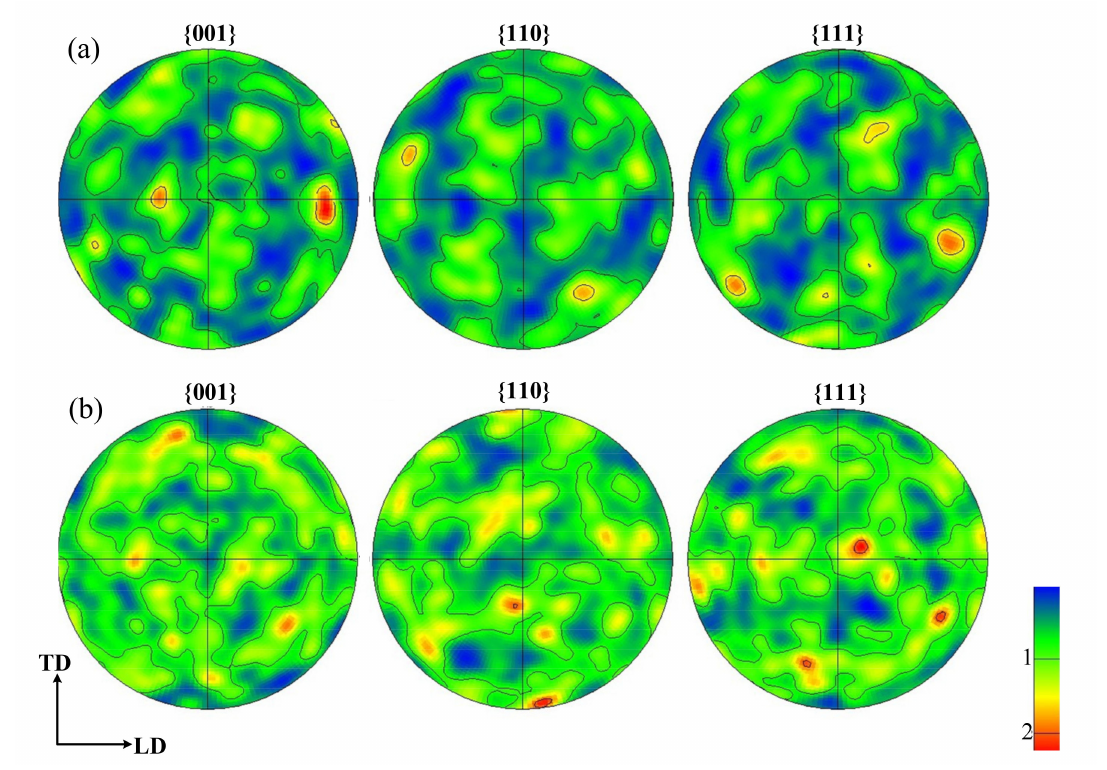
Figure 9. Corresponding pole figures after ( a ) FT and ( b ) LPB processes.